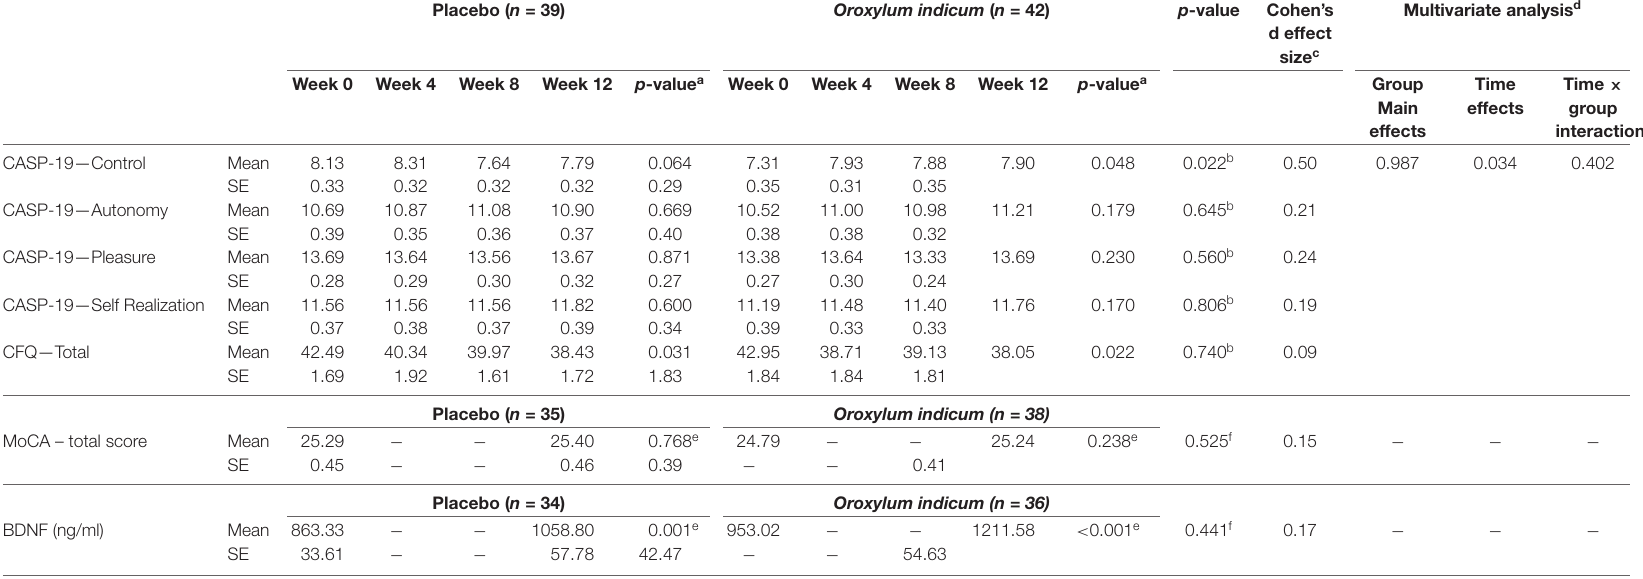
TABLE 6 | Change in questionnaire scores and BDNF concentrations. Placebo ( n = 39) Oroxylum indicum ( n = 42) p